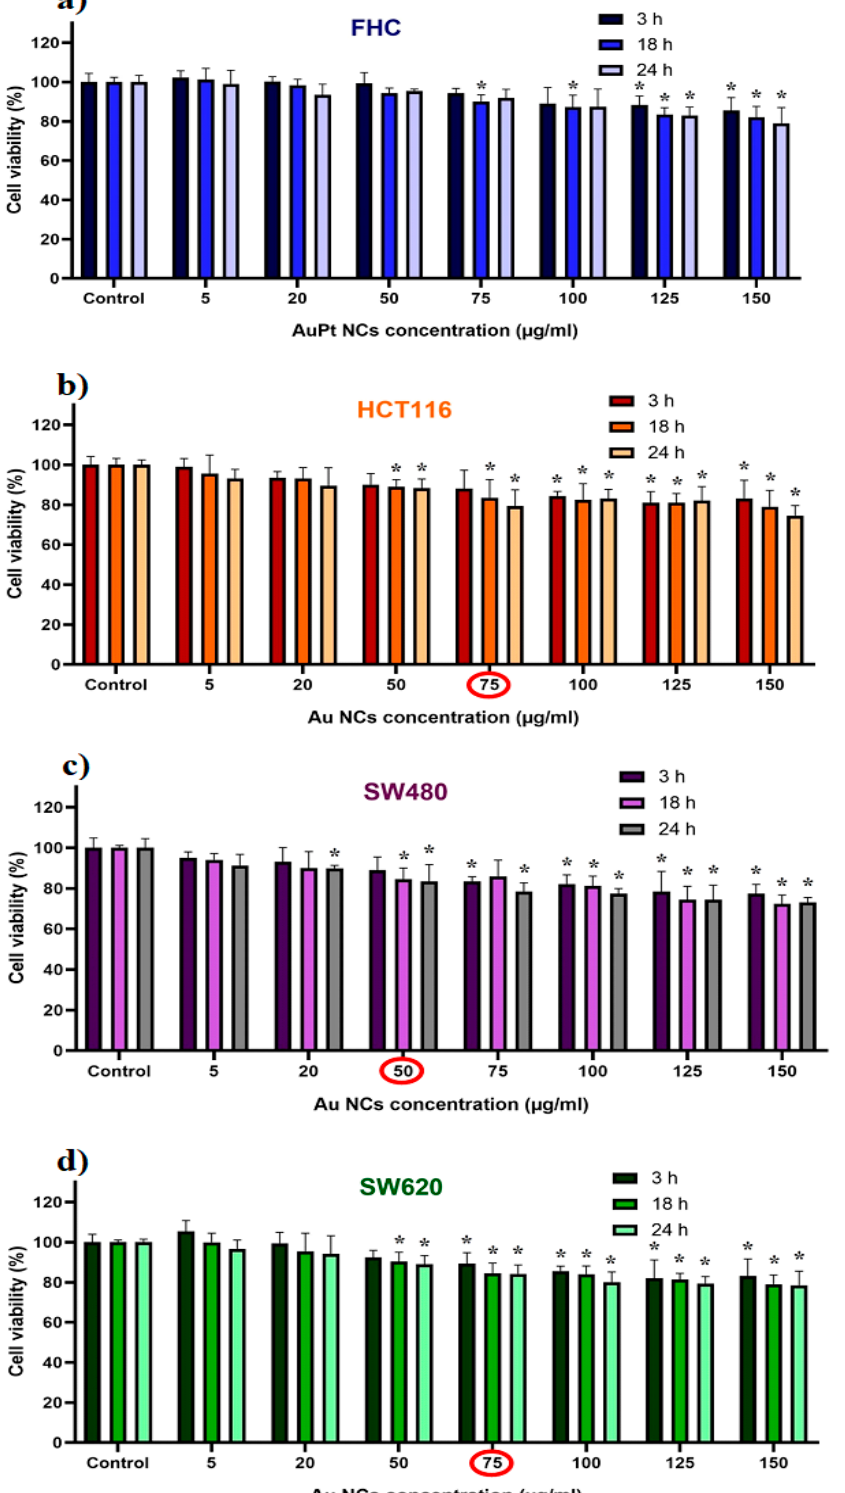
Figure 5. Cytotoxicity of AuPt NCs against ( a ) FHC, ( b ) HCT116, ( c ) SW480, and ( d ) SW620 cells after 3, 18, and 24 h of incubation: data were considered significant when * p < 0.05 versus control. The concentrations of HCT116, SW480, and SW620 cells considered optimal were marked in red.